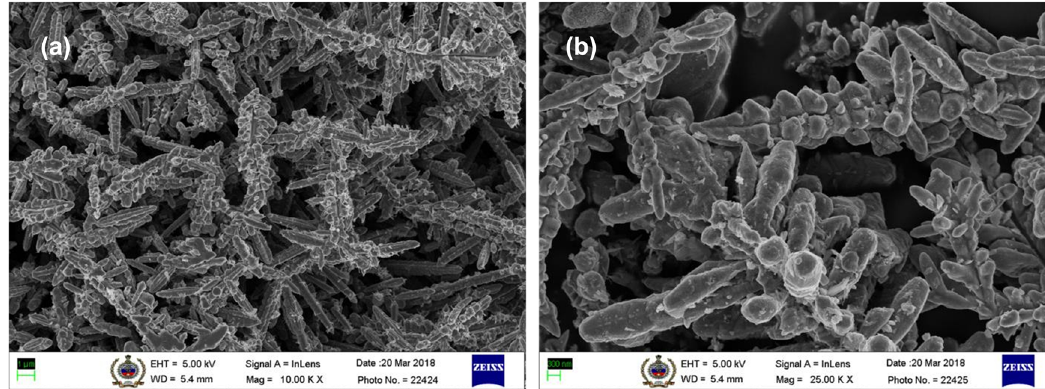
Figure 4: ( a ) and ( b ) SEM images of Cu powder at di ff erent magni fi